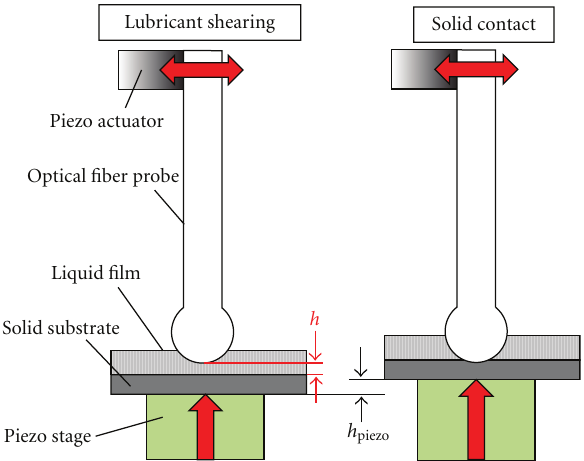
Figure 4: Gap determination procedure in the FWM measure- ments. Shearing gap h is equal to the displacement of the piezo stage until the solid contact occurs, which is represented by h piezo .